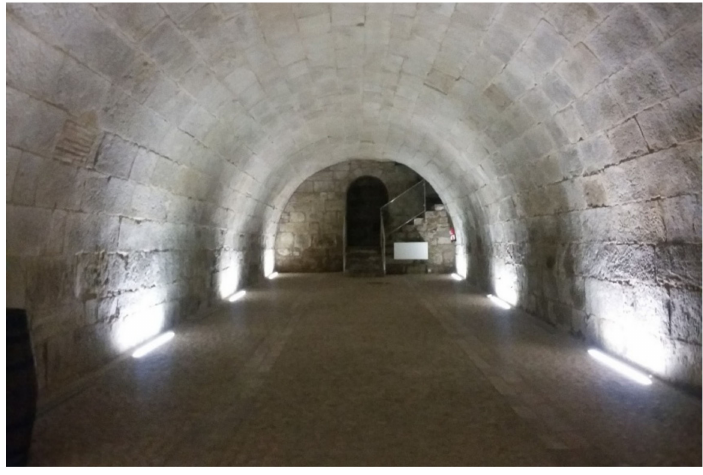
Figure 1. Calado de San Gregorio , Logroño, La Rioja, Spain, before the installation of the TinajAR